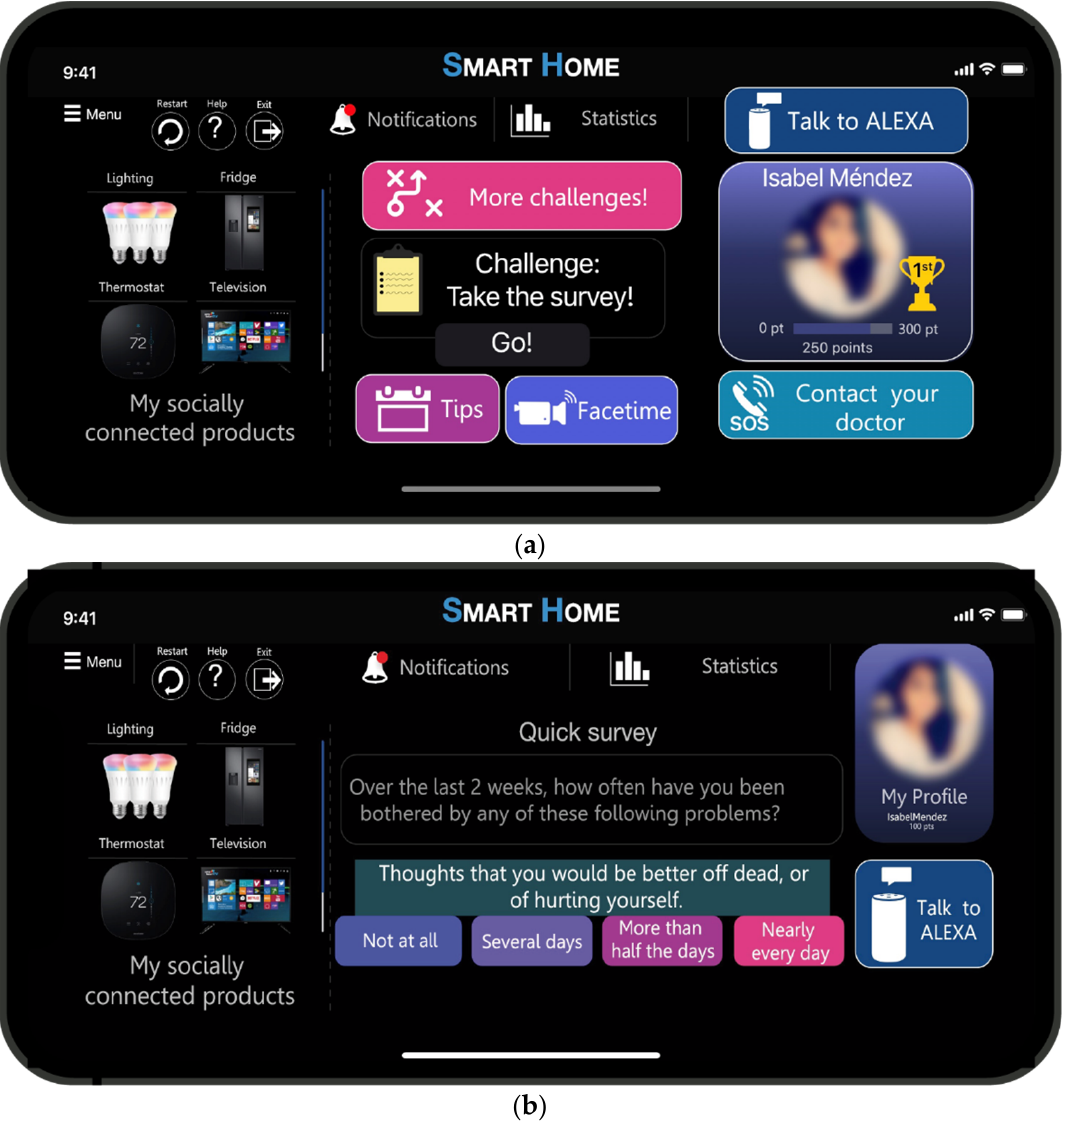
Figure 8. HMI oriented to pre-diagnosis using the PHQ-9: ( a ) Homepage of the gamified HMI; ( b ) Question 9 is depicted in the gamified HMI.